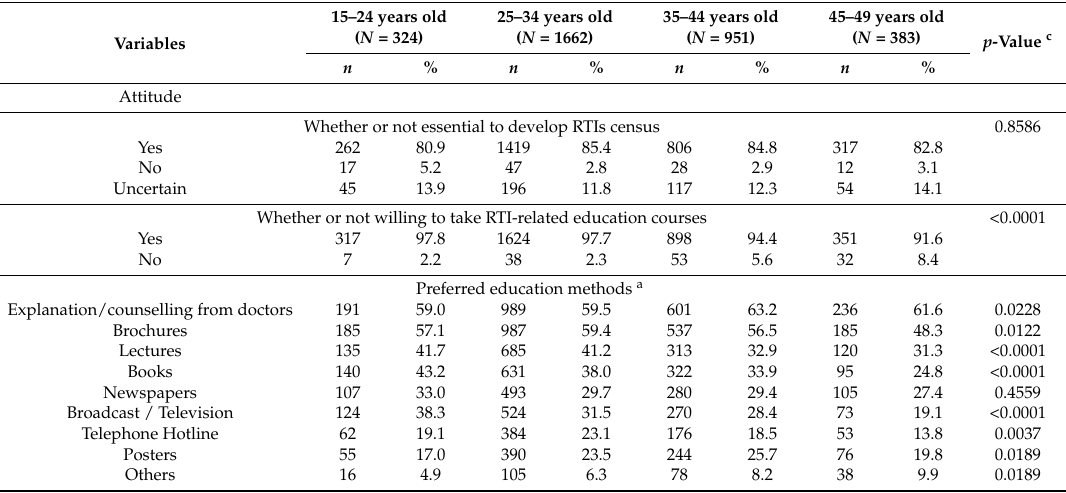
Table 3. RTI-related attitude and practices of the study participants in four age groups